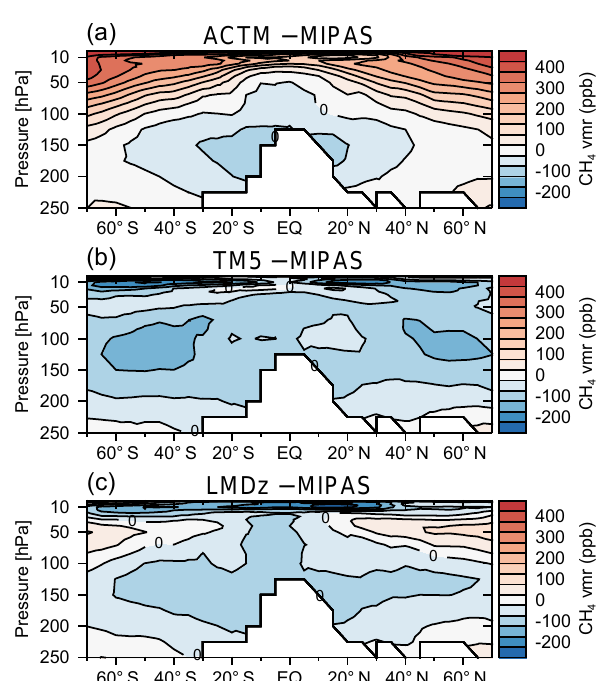
Figure 3. Model–MIPAS differences of stratospheric CH 4 volume mixing ratios (vmr) in parts per billion (ppb). Zonally averaged CH 4 vmr differences are annual means for the year 2010.